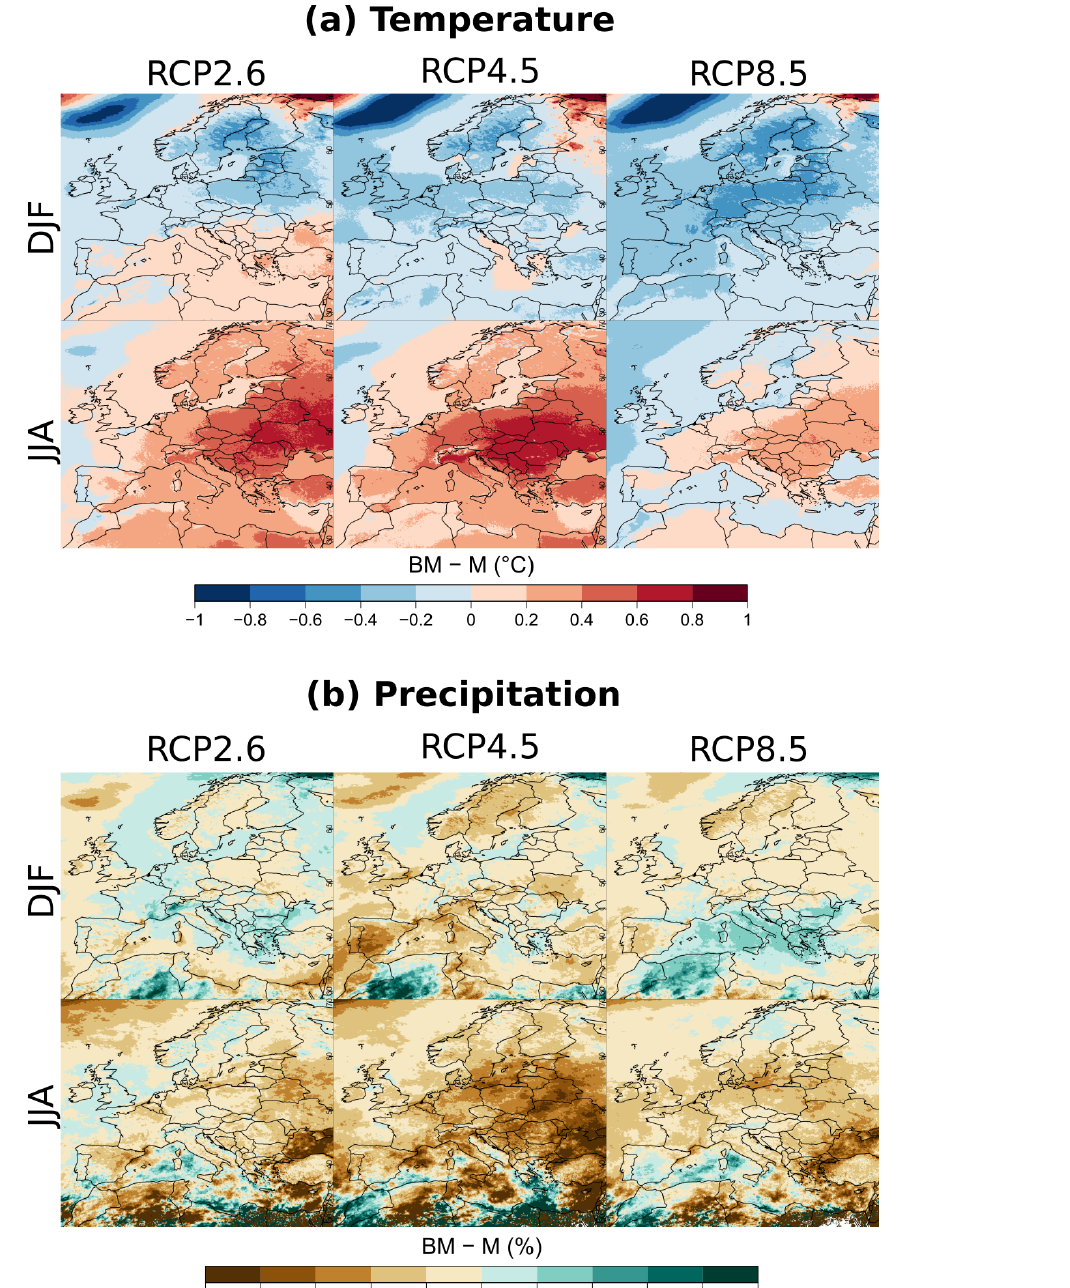
Figure 13. Difference between the “balanced” estimates of the mean projected changes BM k obtained with the QUALYPSO approach and the direct average M k of the climate change responses available for each scenario in winter (DJF) and summer (JJA) at the end of the 21st century (2071–2099) compared to the period 1981–2010 for mean projected changes in (a) precipitation (b)